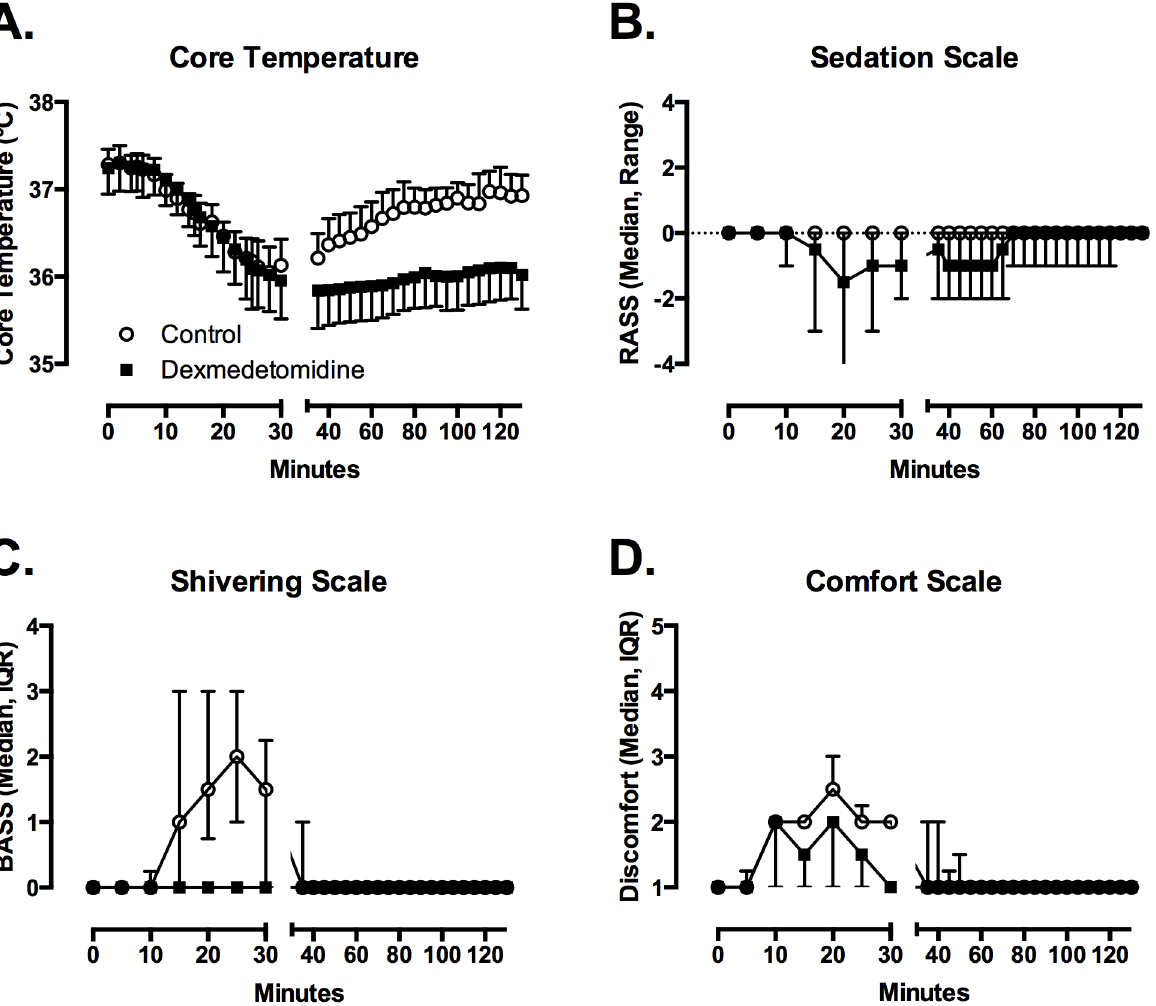
Fig 1. Dexmedetomidine suppresses the shiver threshold through moderate sedation, no shivering and improved comfort. Compared to saline infusion (circles), dexmedetomidine infusion allowed a more prolonged reduction in core temperature (A), with moderate sedation (B), no shivering (C), and slight improvement in comfort (D). Figures depict mean with SD of temperature, median with range for sedation, and median with interquartile range for shivering and comfort scales.